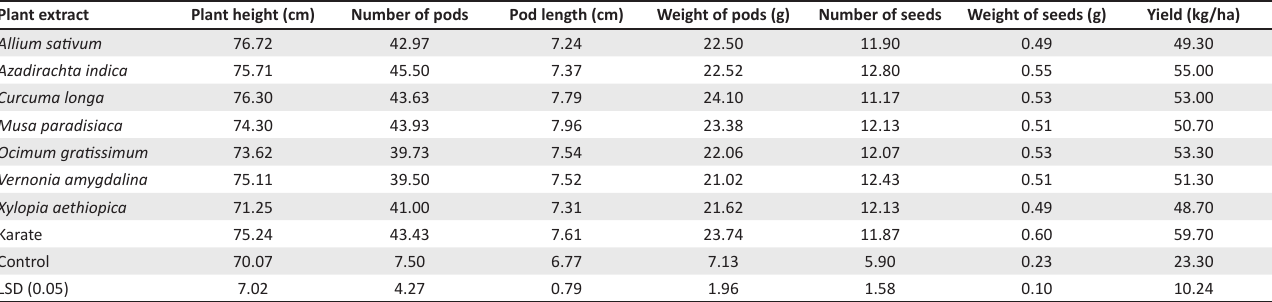
TABLE 4: Effect of selected plant extracts and karate on yield and yield components of mung bean in 2015 cropping season. Plant extract Plant height (cm)